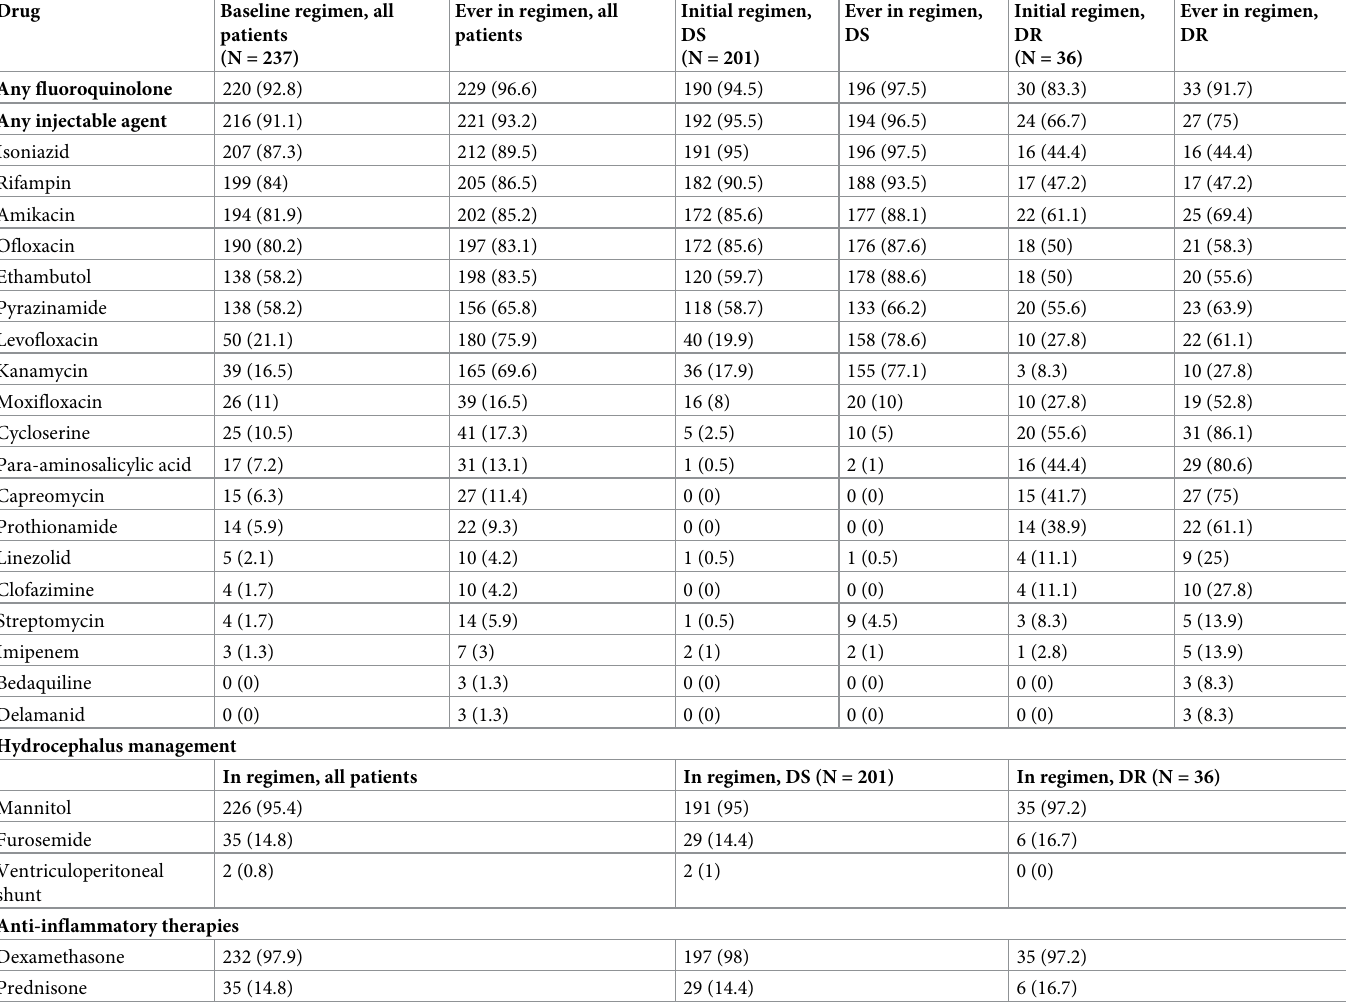
Table 2. Drugs included in baseline treatment regimens and ever in treatment, by drug resistance